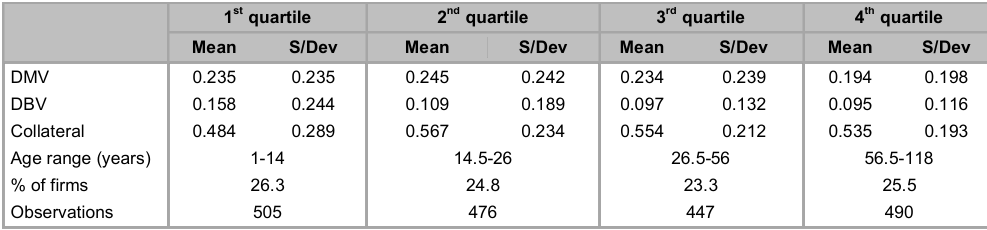
Summary statistics of the main estimation variables across age quartiles